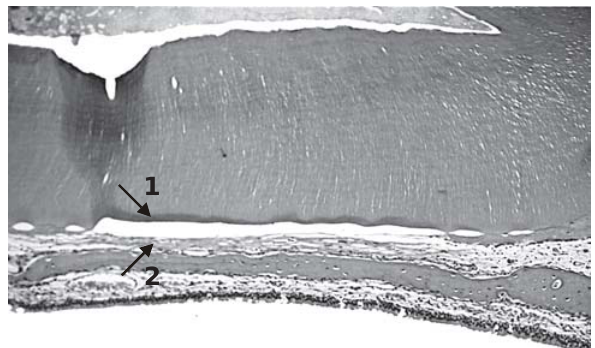
FIGURE 3- Group III. Healthy cementum covering great part of root surface (1). Fibrous connective tissue with fibers oriented parallel to root surface (2). No new attachment is observed in the cementum layer. Hematoxylin-eosin (original magnification X160)